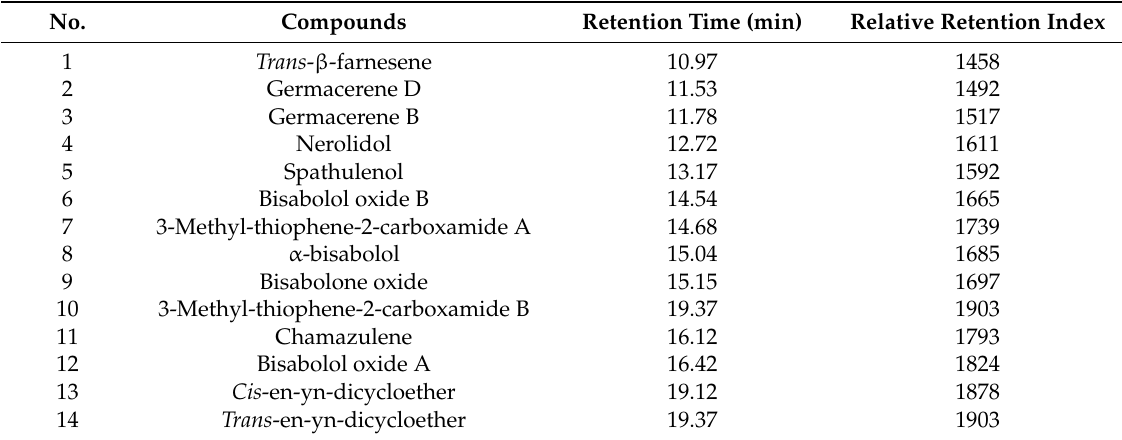
Table 1. Identified chemical compositions in the chamomile essential oil treated with salicylic acid under normal and heat stress